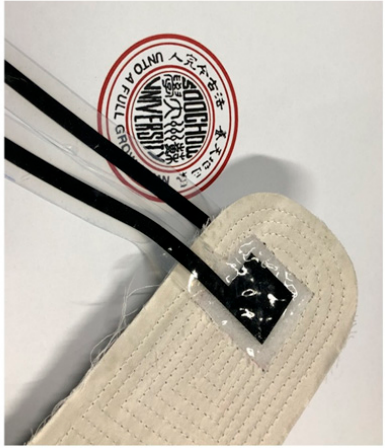
Figure A6. Photo of placing of the sensor on the insole.